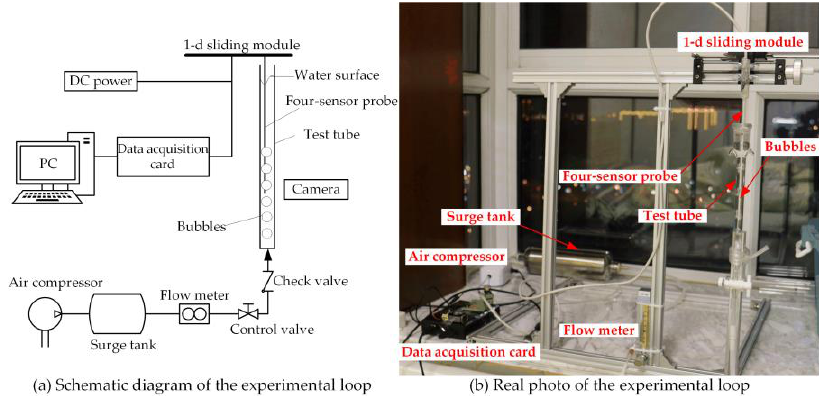
Figure 6. Experiment loop of the present study. ( a ) Schematic diagram of the experimental loop; ( b ) Real photo of the experiment loop.